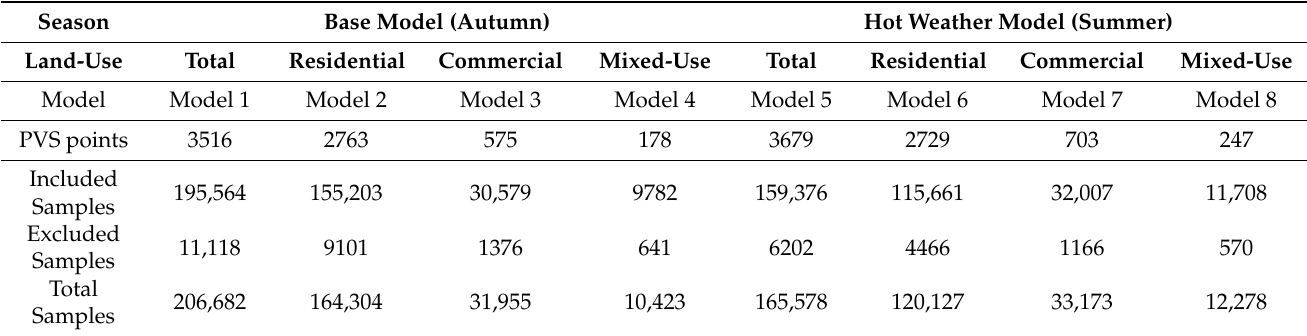
Figure 4. PVS point, automatic weather station (AWS), and air quality monitoring station (AQMS) locations in Seoul. Table 4. The number of samples and survey points by model.